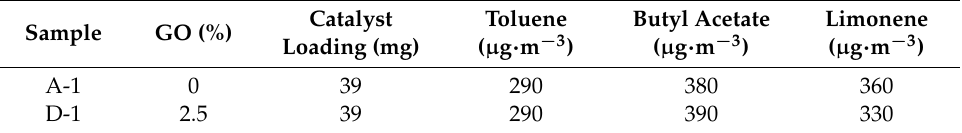
Table 2. Initial concentrations.